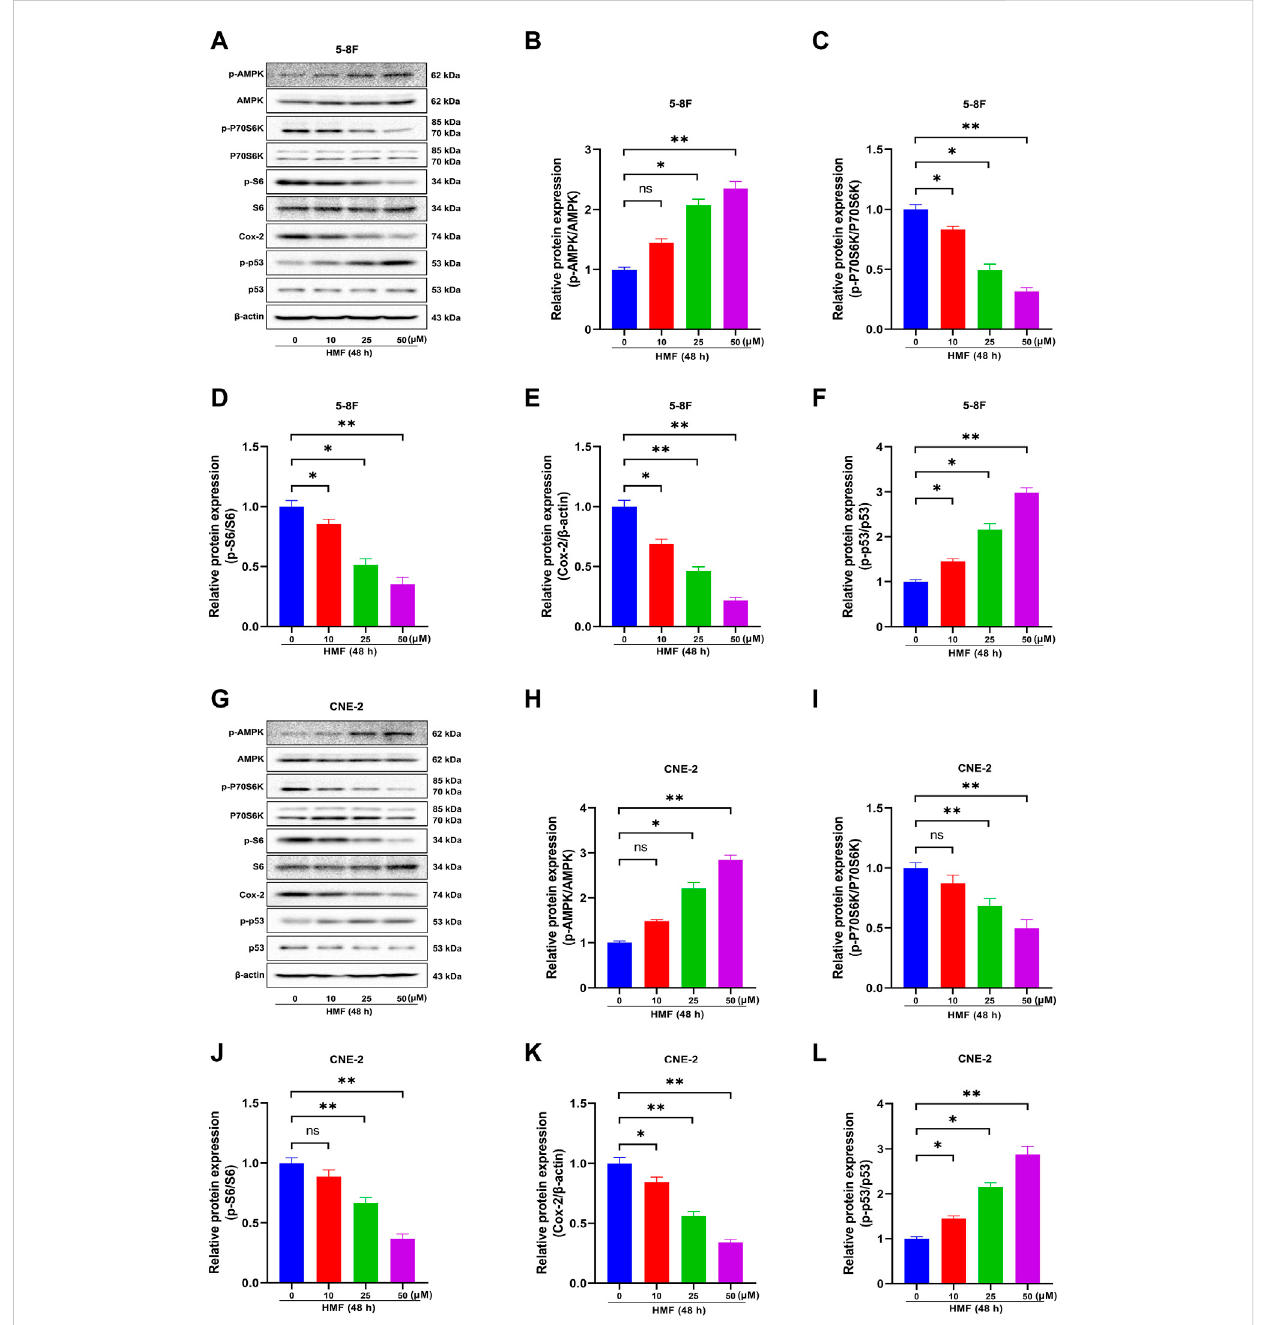
FIGURE 4 Effect of HMF on 5-8F and CNE-2 human nasopharyngeal carcinoma cells through the AMPK signaling pathway. (A,G) 5-8F and CNE-2 cell lysates treated with HMF (0, 10, 25, and 50 μ M) assessed by Western blot analysis with antibodies against p-AMPK, AMPK, p-P70S6K, P70S6K, p-S6, S6, COX-2, p-p53,andp53. β -Actin servedas theloadingcontrol. (B – D) and (H – J) Quanti fi cationofphosphorylationexpressionlevelsofkeyAMPK-mTORpathway molecules (p-AMPK/AMPK, p-P70S6K/P70S6K, and p-S6/S6) in two NPC cells lines. (E,K) Quanti fi cation of COX-2 expression levels. (F,L) Quanti fi cation of p53 phosphorylation levels. All data are described as the mean ± SD of three independent and repeated experiments. Compared to the control group (0 μ M): * p < 0.05, ** p < 0.01; ns, no signi fi